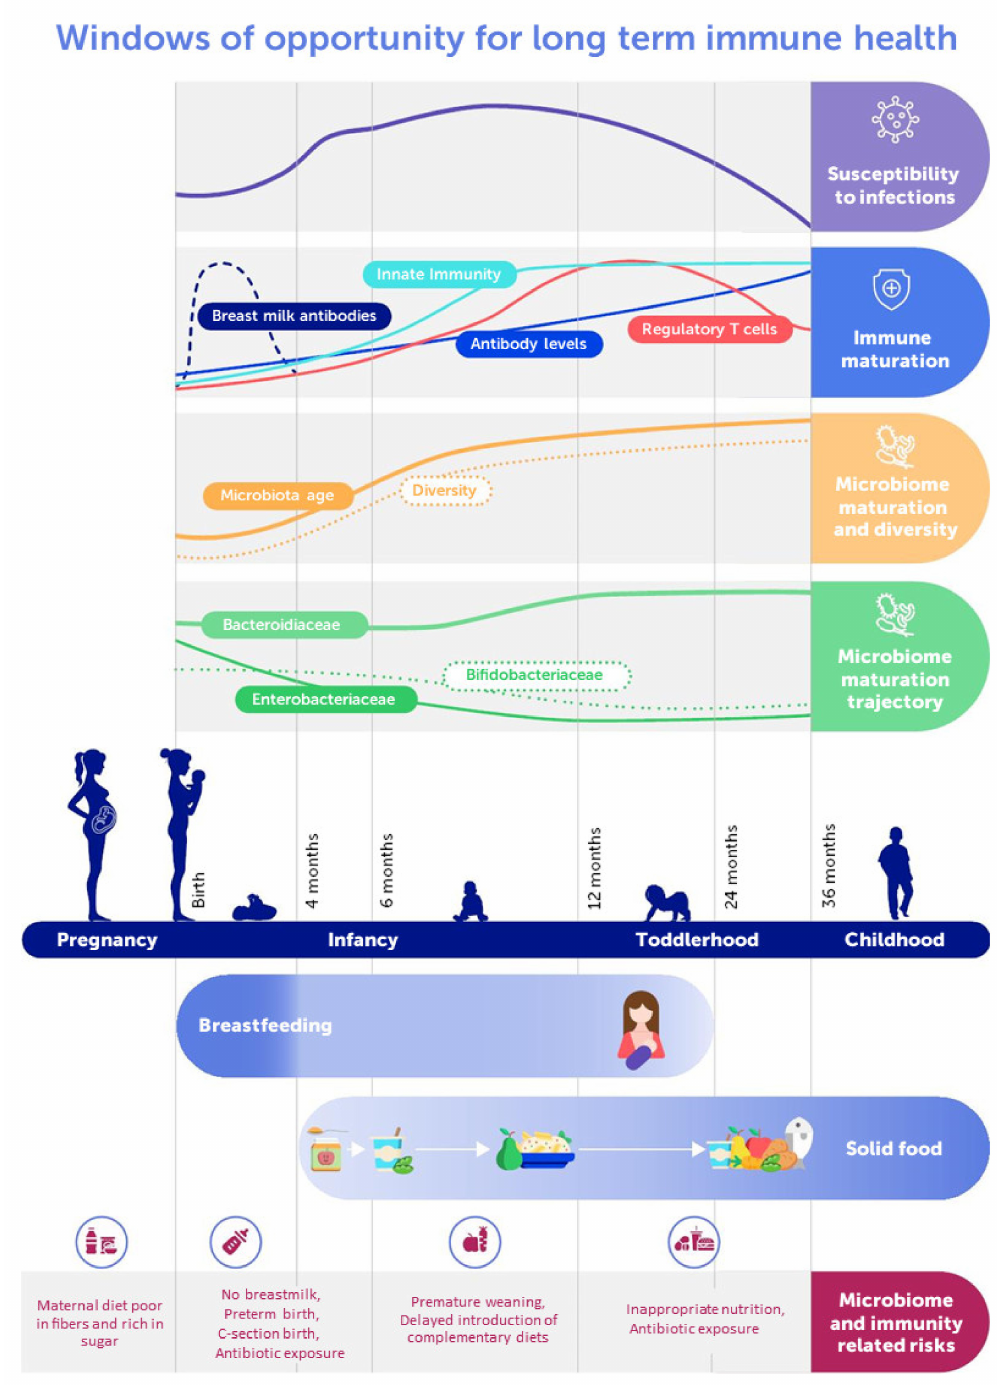
Figure 1. Schematic representation of the early life gut microbiome and immune development dynamics with feeding recommendations and major risk